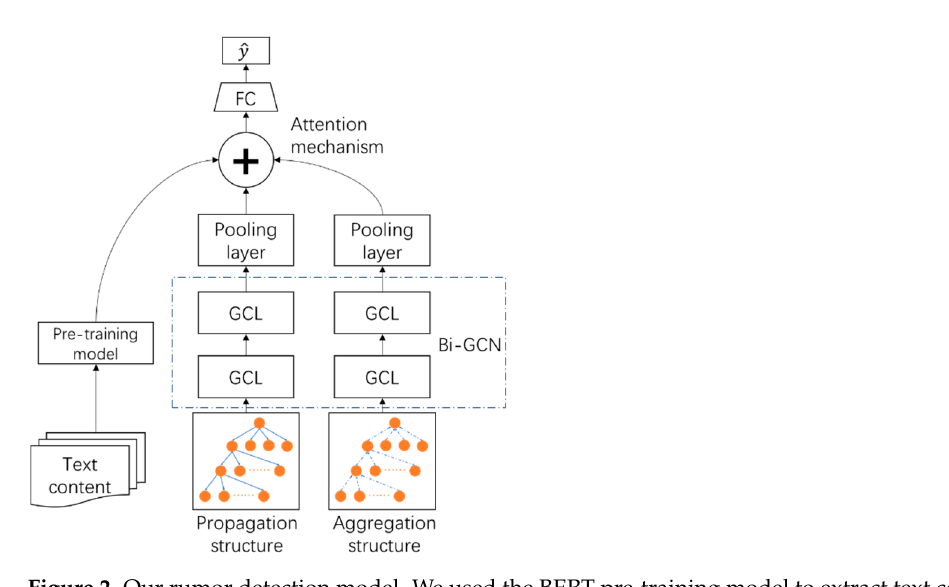
Figure 2. Our rumor detection model. We used the BERT pre-training model to extract text content features, extracted the rumor propagation structure and aggregation structure through Bi-GCN, and fused multimodal features through the attention mechanism; finally, the results were obtained by the fully-connected neural network classifier.